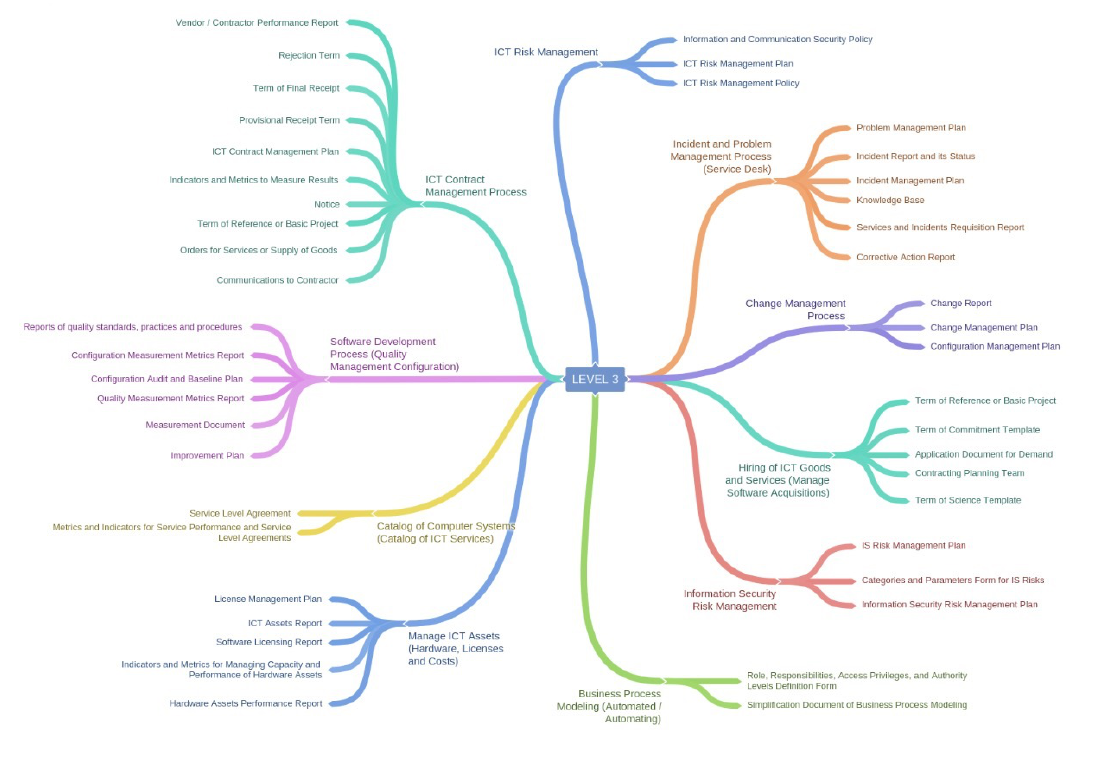
Figure 4. Processes of Kit